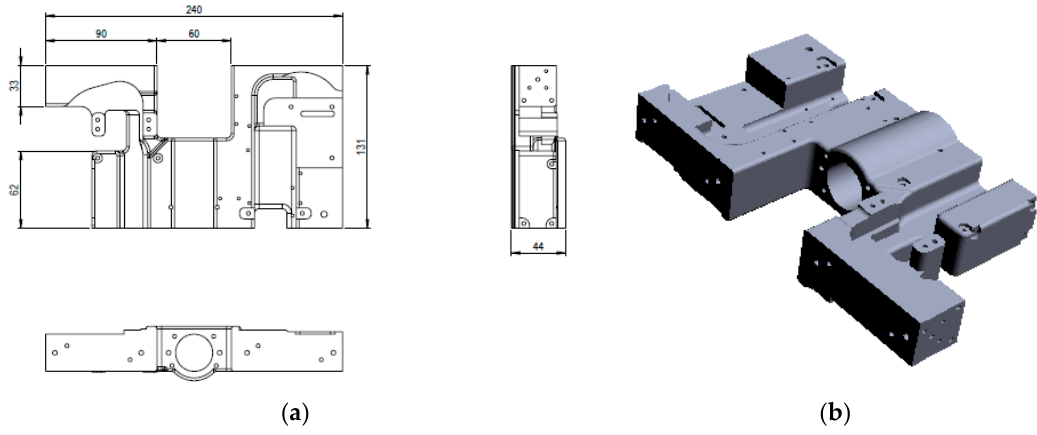
Figure 1. Hydraulic block of one railway installation: ( a ) 2D technical drawing; ( b ) 3D CAD model.